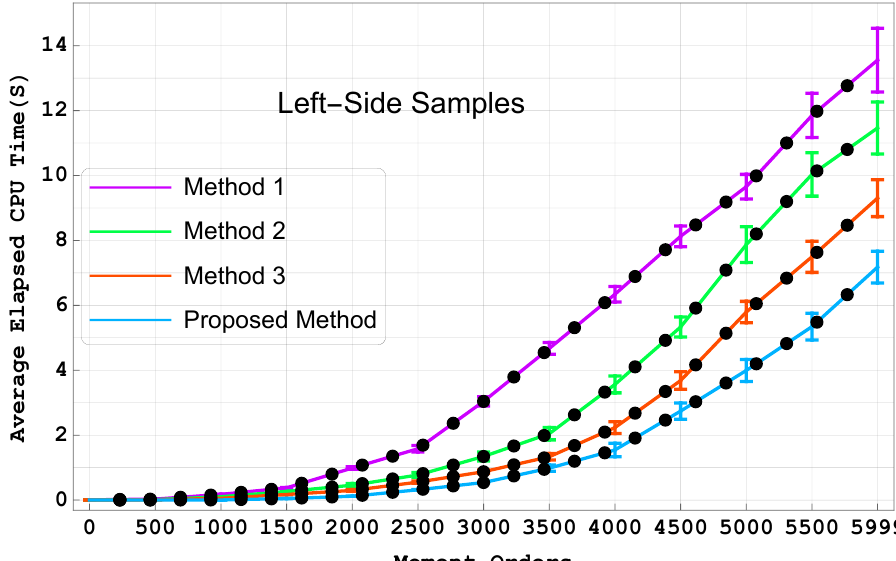
Figure 16. Average elapsed CPU times in seconds with error bar: Computation of full set of KMs for left-side samples of the speech signal of size 3000 shown in Figure 15b. Assuming p = 0.5.